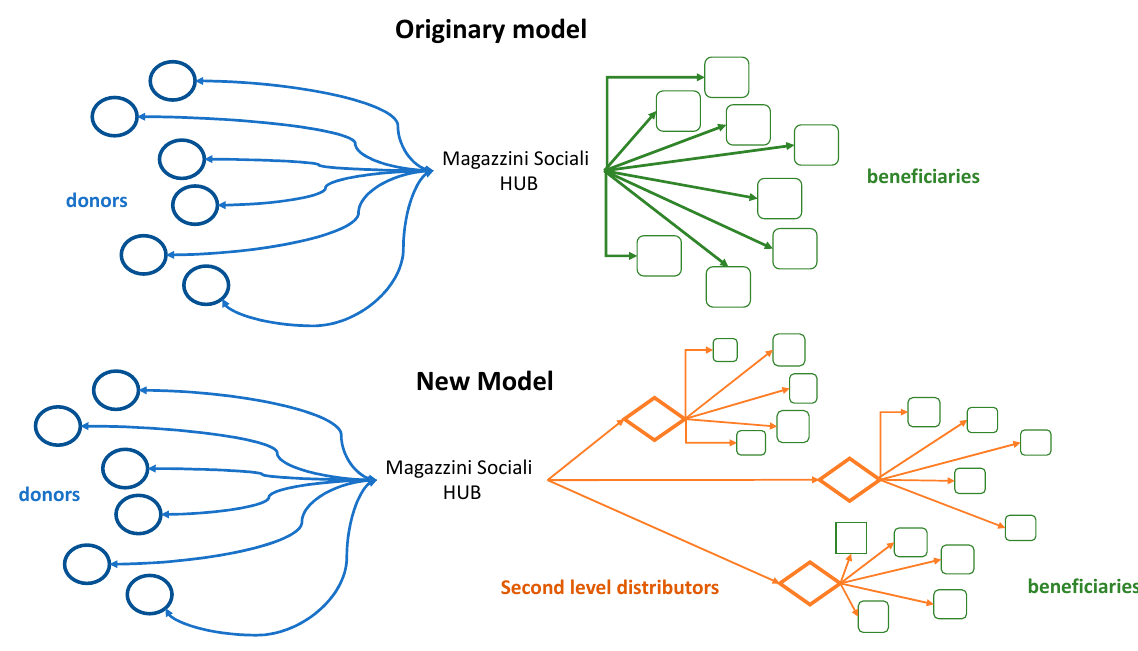
Figure 3. The Magazzini Social distributive model.